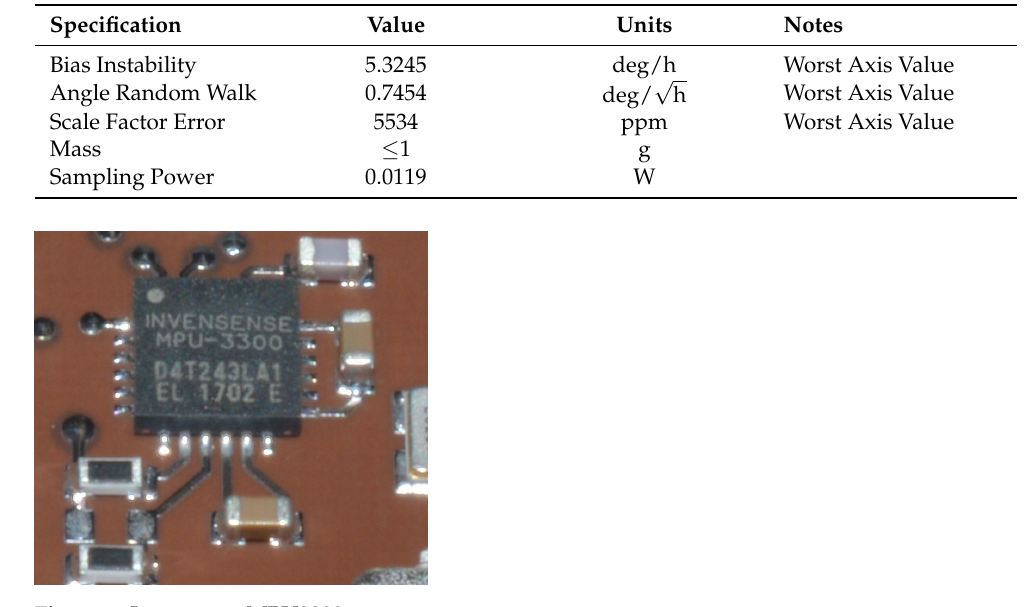
Figure 6. Invensense MPU3300